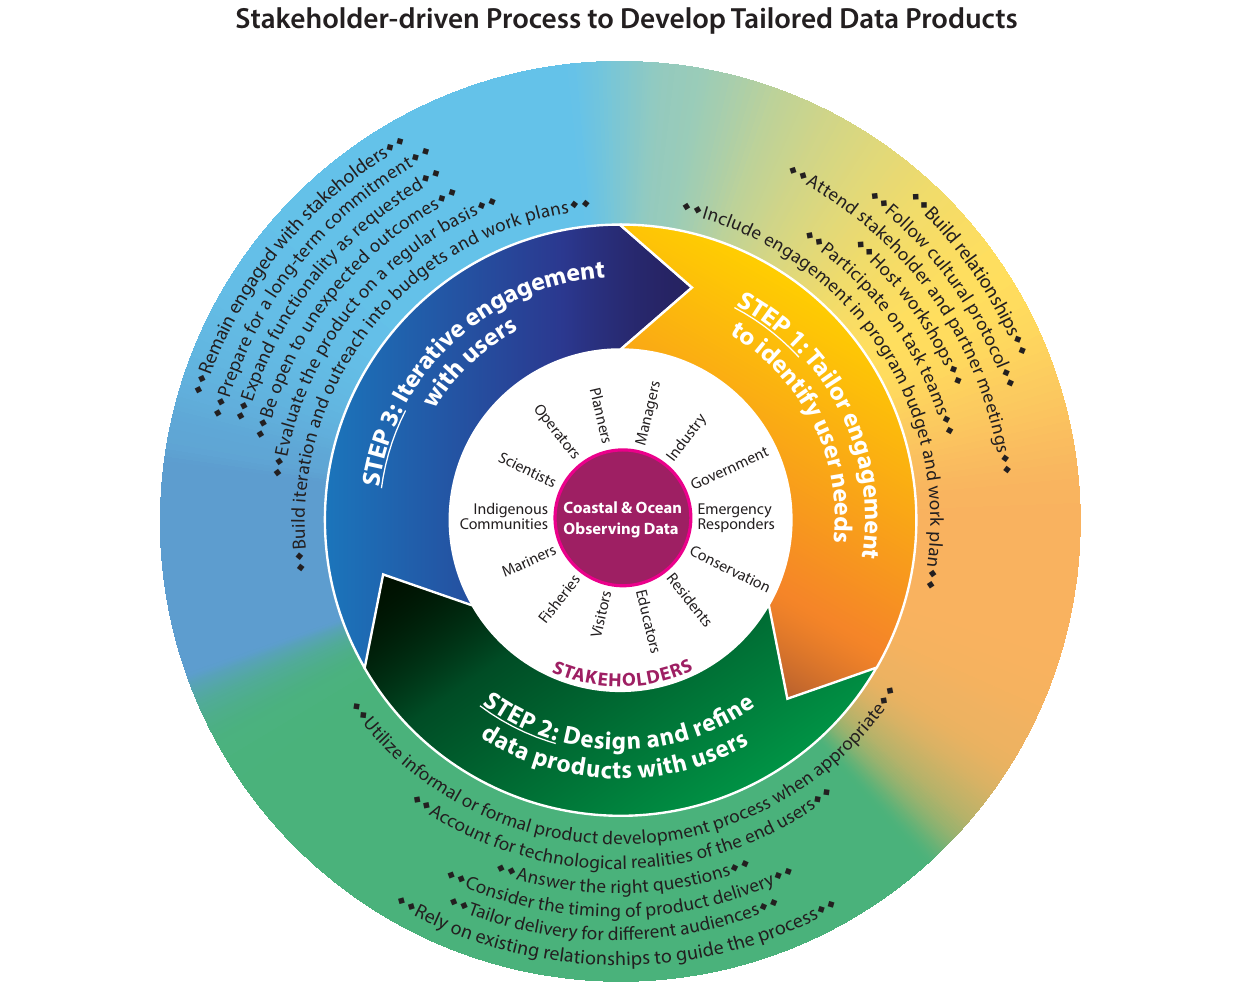
FIGURE 1 | This figure illustrates the stakeholder-driven process to develop tailored data products presented in this paper. The process starts in the center, with various stakeholders and their interactions and needs related to coastal and ocean observing data. Starting here is a reminder to first set the intention to operate a stakeholder-driven process. The three steps in the next rung of the image represent the three steps of this iterative, non-linear process—a continuum in which the three steps overlap and blend into each other as well as repeat. The outer rung includes the various elements or best practices to draw from when working through the various stages of this